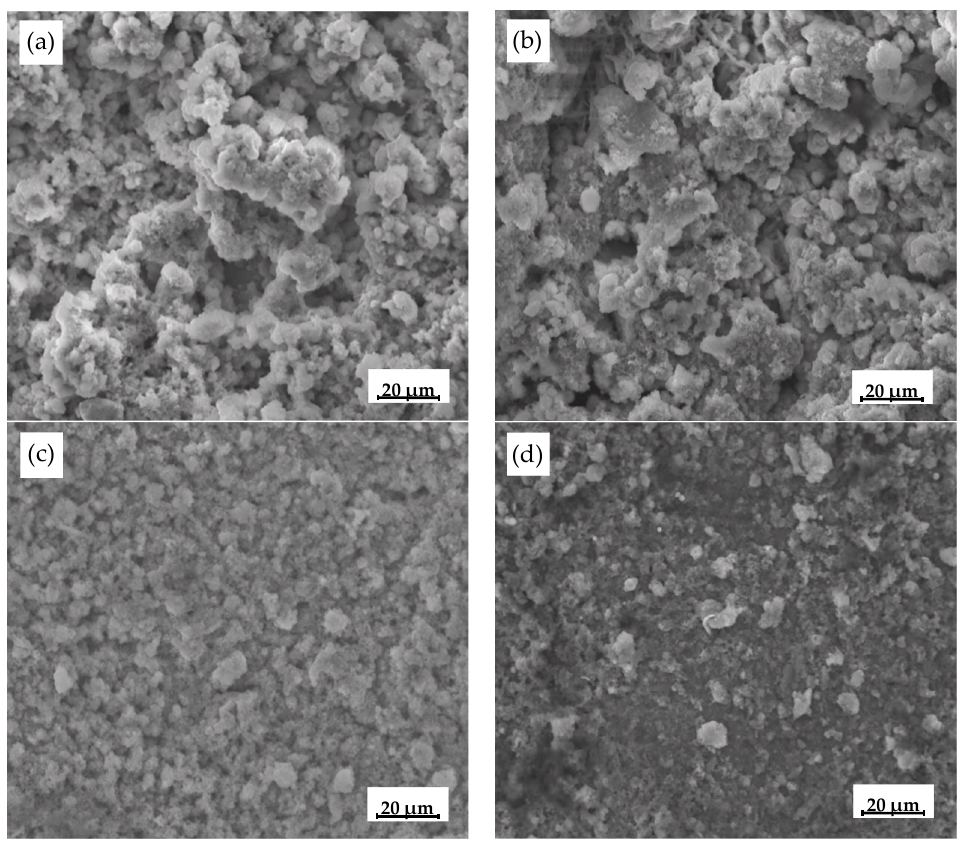
Figure 5. SEM images of corrosion product formed on oxide scale electrode after 40 cycles: ( a ) type I ; ( b ) type II; ( c ) type III; ( d ) type IV .